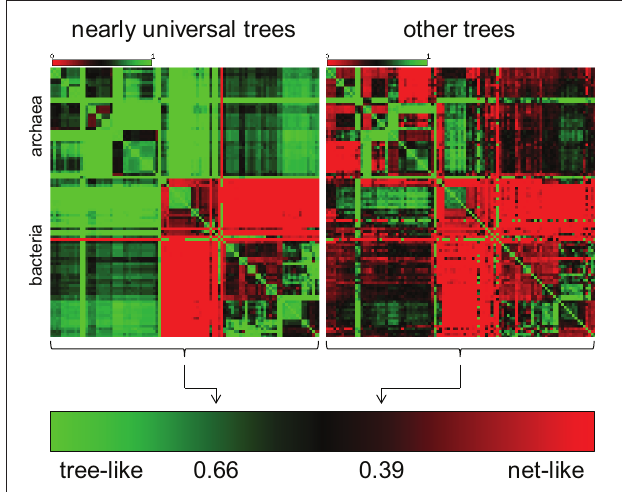
FIGURE 3 | Tree-like (vertical) and web-like (horizontal) contributions in the evolution of nearly universal genes and the entire phylogenetic forest. The two heat maps schematically depict comparison of bacterial and archaeal genomes as described previously (Puigbo et al., 2010).